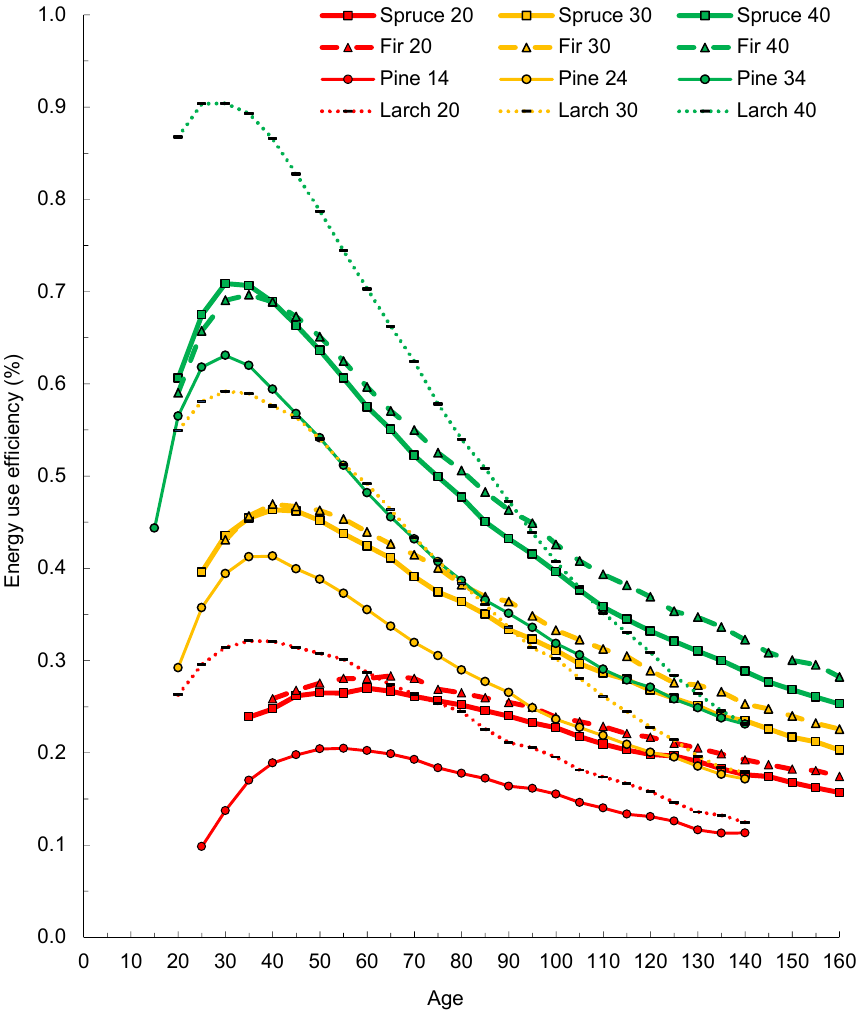
Figure 6. Development of the efficiency of the solar energy use by coniferous stands depending on the age of the stand and the site index (20, 30, 40 for spruce, fir and larch; 14, 24, 34 for pine). The development of the efficiency of solar energy utilization by coniferous stands from the point of view of forest management can be seen in Table 6. The decrease in the efficiency of solar energy use by the spruce and fir stands with the lowest site index be- gins at the age of 60–70 years, in the case of pine stands at the age of 45–65 years and larch stands at the age of 45–50 years. In stands with a higher site index, the efficiency of solar energy use decreases already after reaching the age of 30 ‒ 40 years. Table 6. The efficiency of solar energy utilization by coniferous stands with low, medium and high site index.